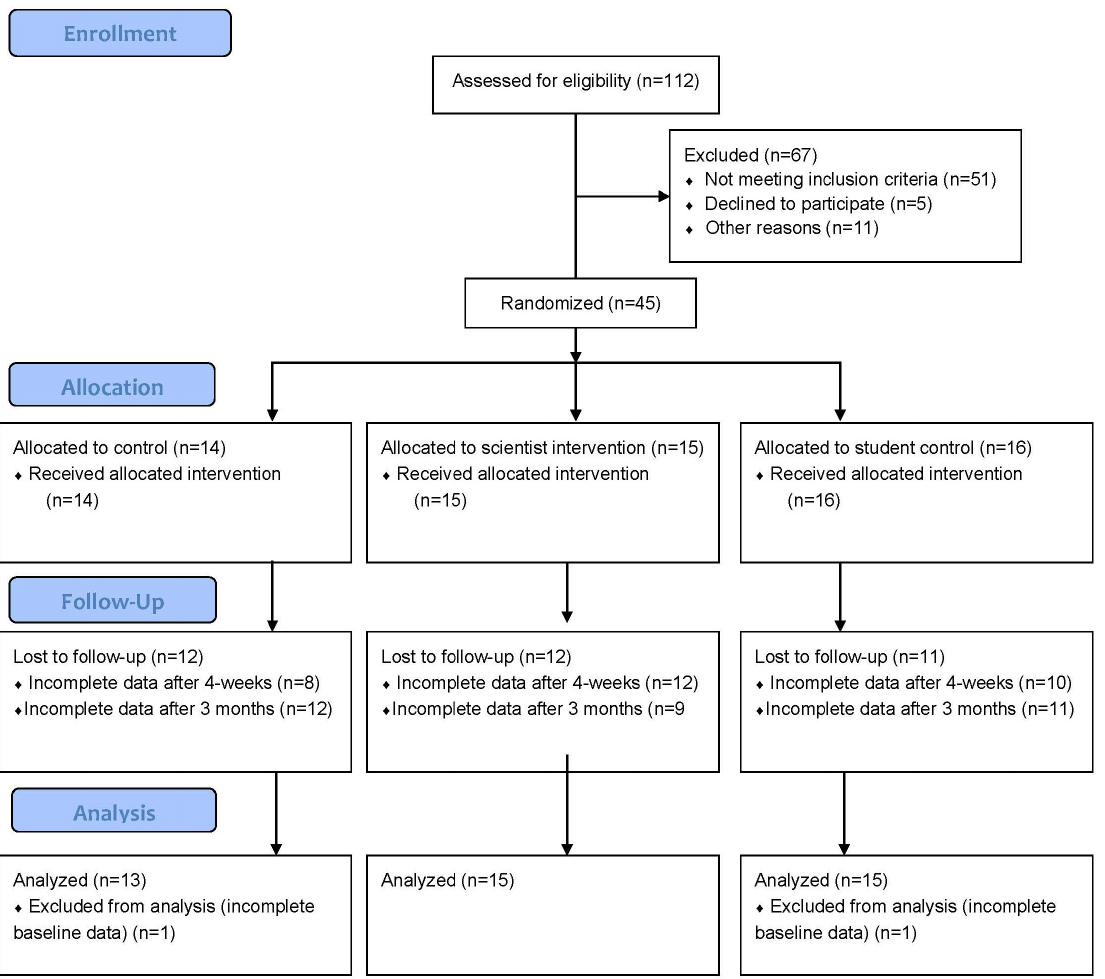
Figure 3. CONSORT flow diagram.